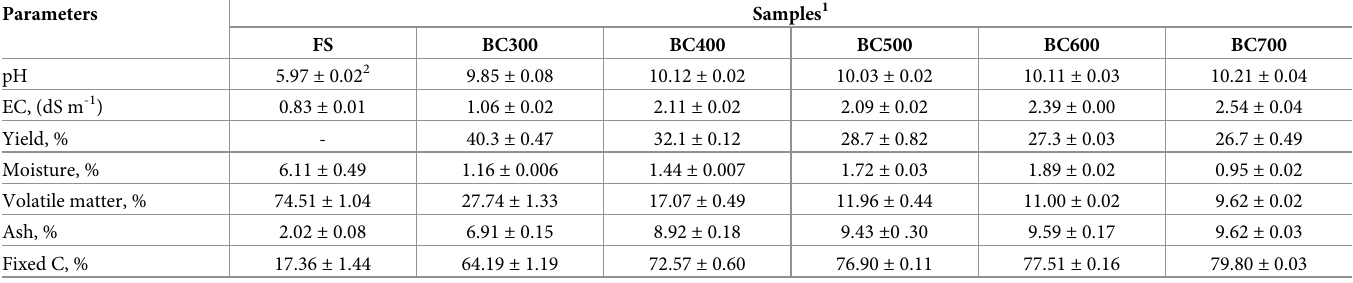
Table 1. pH, Electrical Conductivity (EC), and approximate analysis of Olive Mill Solid Waste-derived Biochar (OMSW-BCs) samples as affected by pyrolysis temperature.